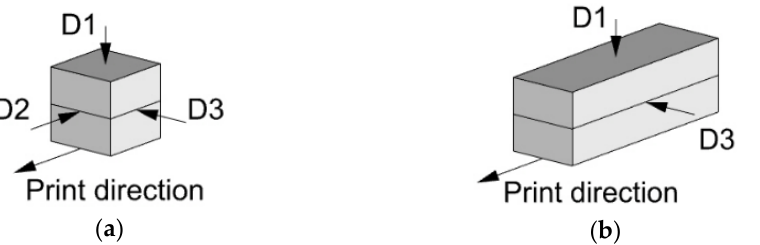
Figure 7. Testing directions in: ( a ) uniaxial compression test and ( b ) bending